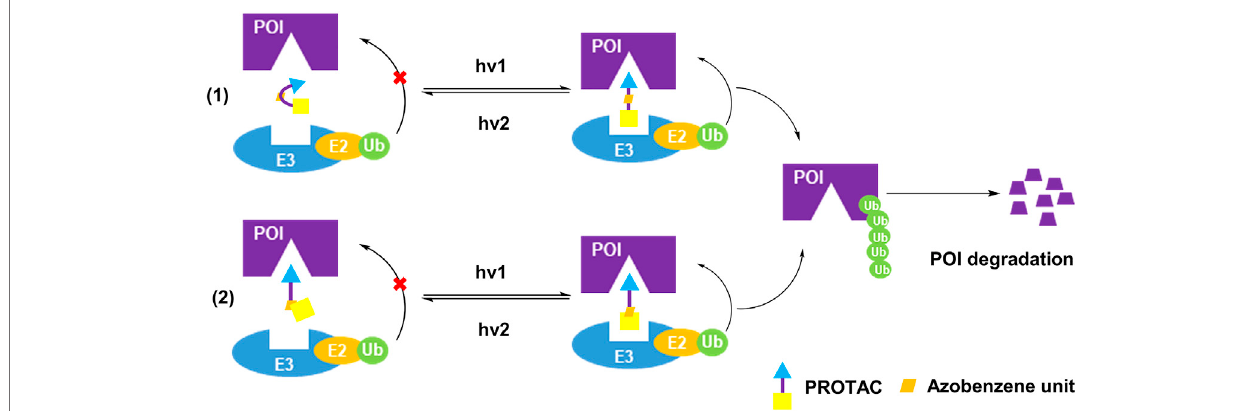
FIGURE 3 | Two action modes of photoswitching PROTAC strategy.